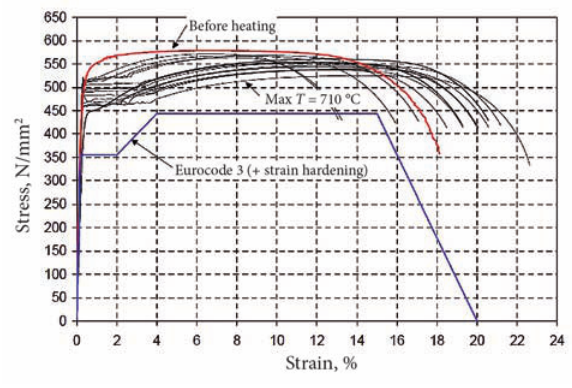
Fig. 6. Tensile test results of structural steel S355 J2